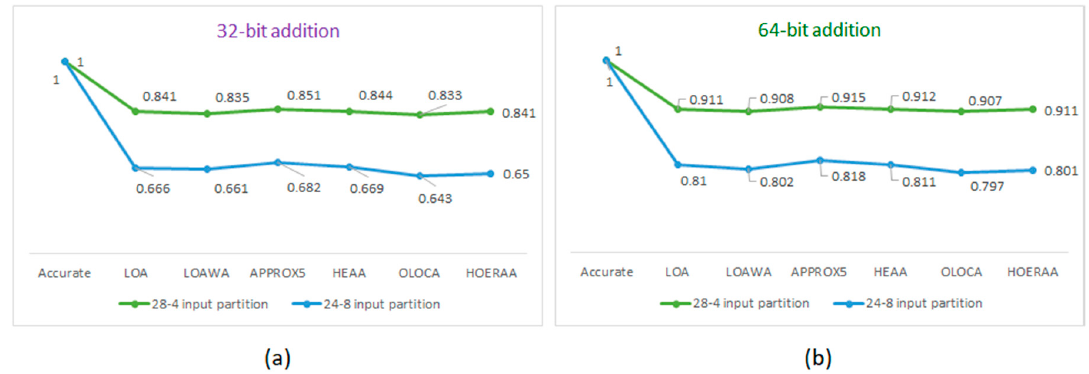
Figure 3. Normalized power-delay product (PDP) plots of accurate and approximate ASIC-based adders corresponding to: ( a ) 32-bit addition and ( b ) 64-bit addition.